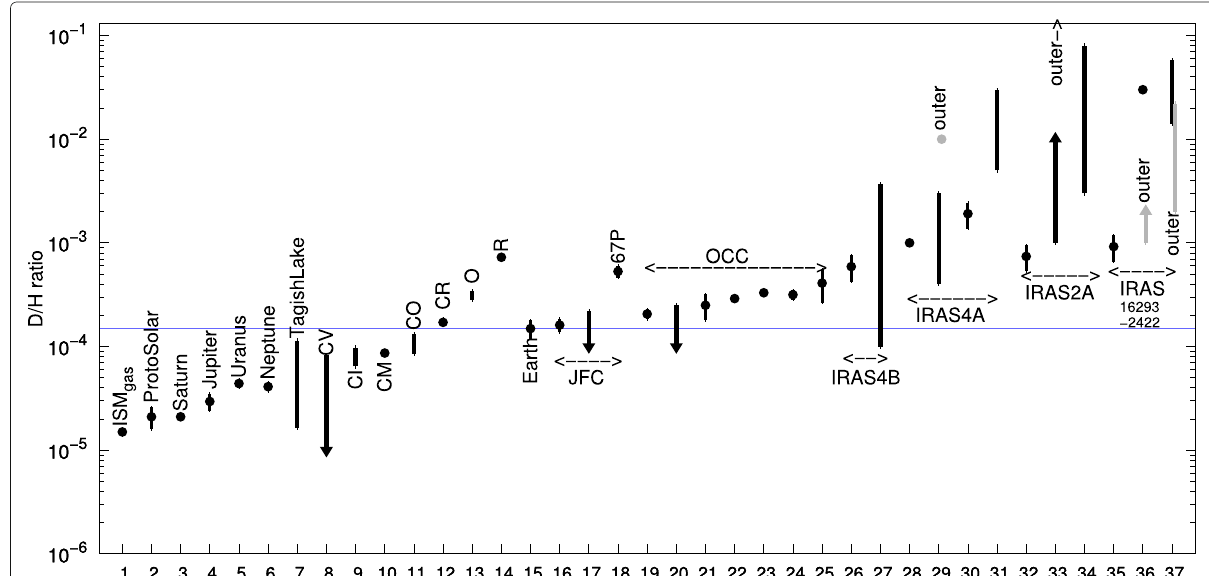
Fig. 10 D/H ratios of various solar system and extrasolar substances. Data and their references noted by numbers 1-37 are shown in Appendix B. Blue-line represents the D/H ratio of Bulk Earth (15). Numbers 7-14 are chondrites. JFC: Jupiter family comets. OCC: Oort cloud comets. For other details, see Appendix